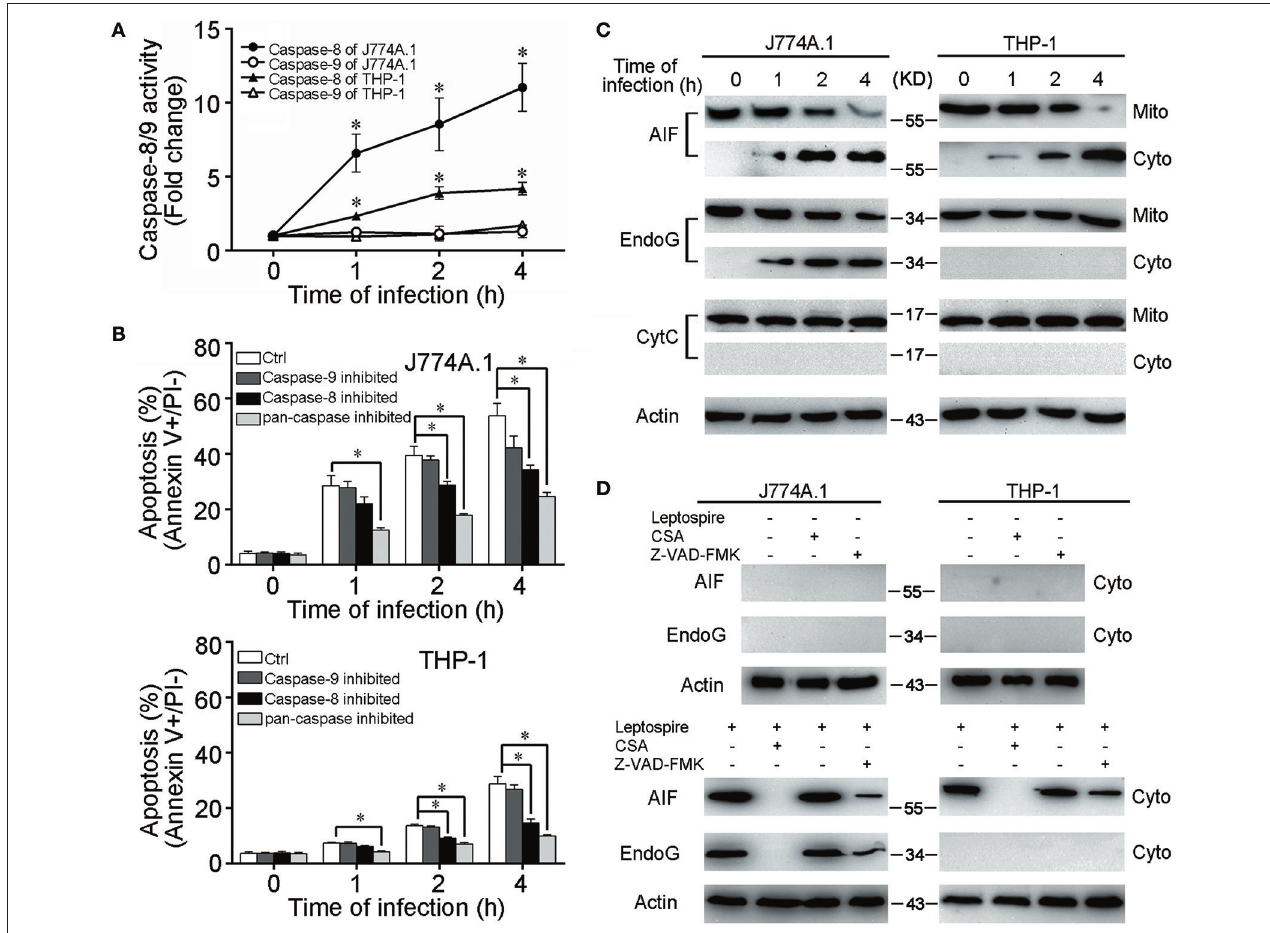
FIGURE 2 | Caspase-8/9 activation and mitochondrial release of AIF and EndoG in leptospire-infected macrophages. (A) Caspase activation during L. interrogans strain Lai infection. Macrophages were incubated with leptospires at an MOI of 100 for the indicated times. Cell lysates were prepared, and the activities of caspase were determined with the fluorogenic substrates Ac-IETD-AFC (for caspase-8), and Ac-LEHD-AFC (for caspase-9). Bars show the mean ± SD of three independent experiments. * p < 0.05 vs. caspase activation in each macrophage type before infection. The value for the uninfected control was set at one-fold. (B) Apoptosis of macrophages pretreated with caspase-8, 9 or pan-caspase inhibitor infected with L. interrogans strain Lai. Cells were pretreated with Z-IETD-FMK, Z-LEHD-FMK, Z-VAD-FMK to inhibit the activation of caspase-8, caspase-9 or pan-caspase. Bars show the mean ± SD of three independent experiments. * p < 0.05 vs. apoptotic ratios in each macrophage type infected with the spirochete for 1, 2, or 4h but unpretreated with inhibitor. (C) The release of AIF, EndoG and CytC from mitochondria in the macrophages during infection with leptospires for the indicated times. (D) CSA or Z-VAD-FMK blockage of AIF and EndoG release from mitochondria. Macrophages were incubated with or without leptospires at an MOI of 100 for 4h. Representative results of three experiments with consistent results are